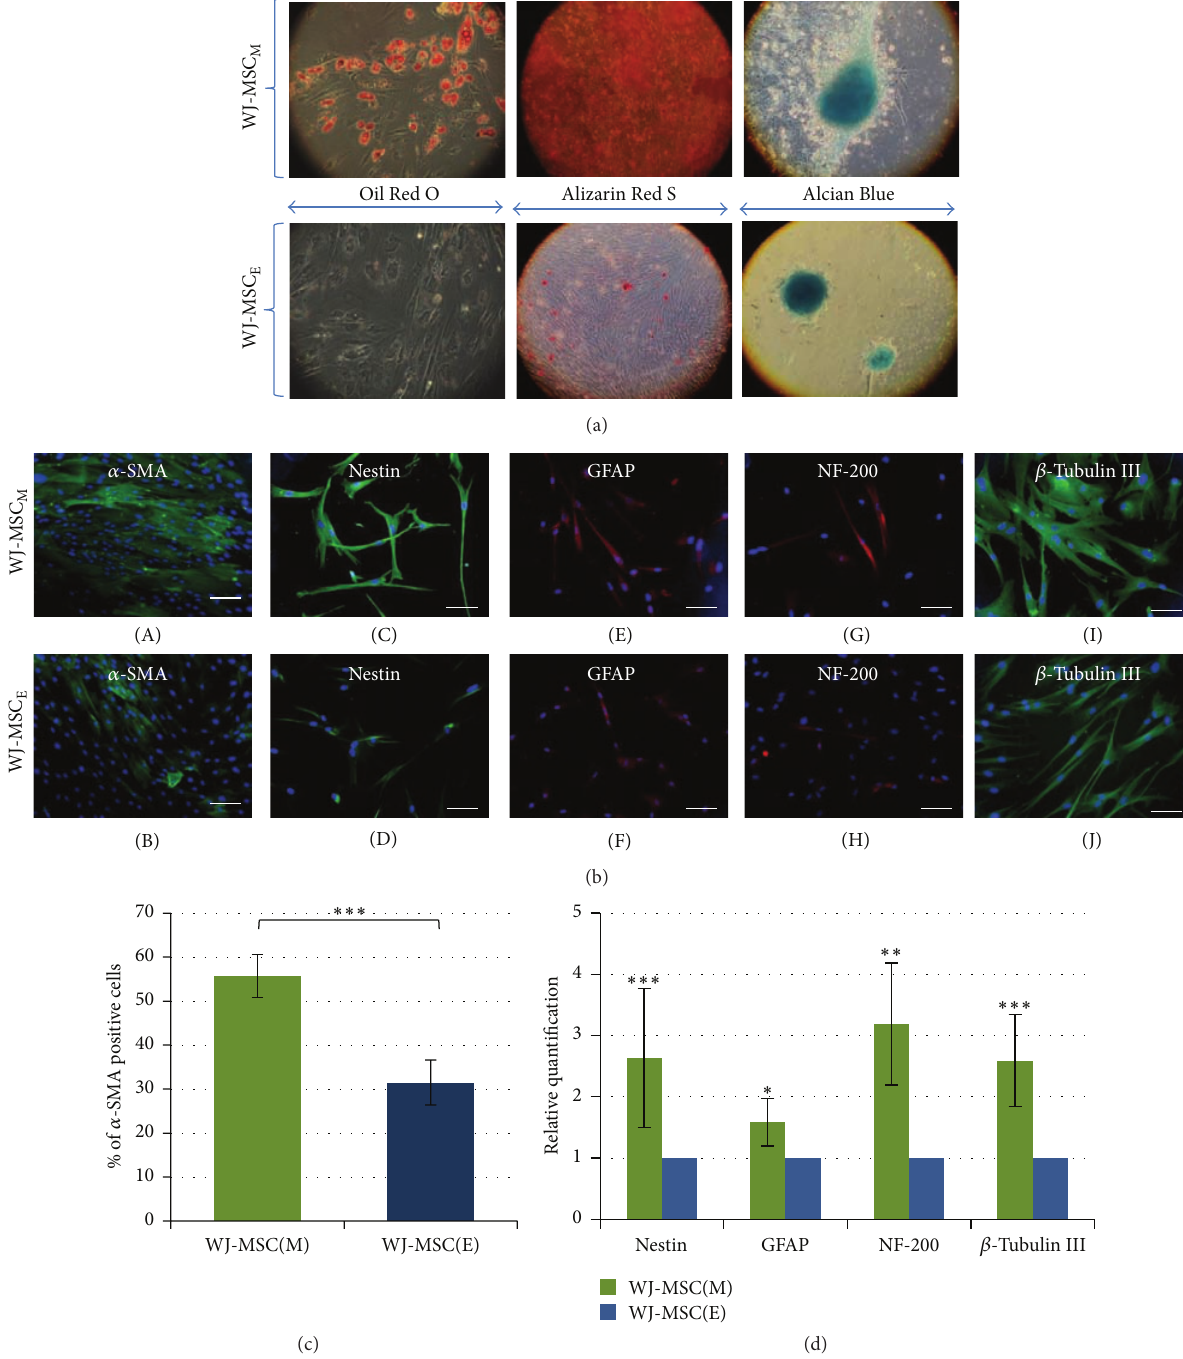
Figure 3: (a) Multilineage mesodermal differentiation potential of WJ-MSC. Positive results of differentiation were noticed exclusively in WJ-MSC(M) with only exception of slightly positive chondrogenesis observed in WJ-MSC(E) cultures. (b) Neural/neuronal differentiation of WJ-MSC. Expression of neural/neuronal markers was found on higher levels in mechanically than enzymatically isolated cells. Scale bars: 100 𝜇 m. (c) 𝛼 -SMA expression analysis. In mechanically isolated MSC a higher expression of primitive cell marker 𝛼 -SMA has been observed. The results present mean values of 3 isolations ± SD, ∗∗∗ 𝑝 < 0.001 . (d) Quantitative neural/neuronal markers mRNA analysis. Relative genes expression of WJ-MSC(M) at 2nd-3rd passages normalized to the reference gene ACTB was compared to WJ-MSC(E) as calibrator group. The results are presented as mean values of 3 isolations ± SD; ∗ 𝑝 < 0.05 ; ∗∗ 𝑝 < 0.01 ; ∗∗∗ 𝑝 < 0.001